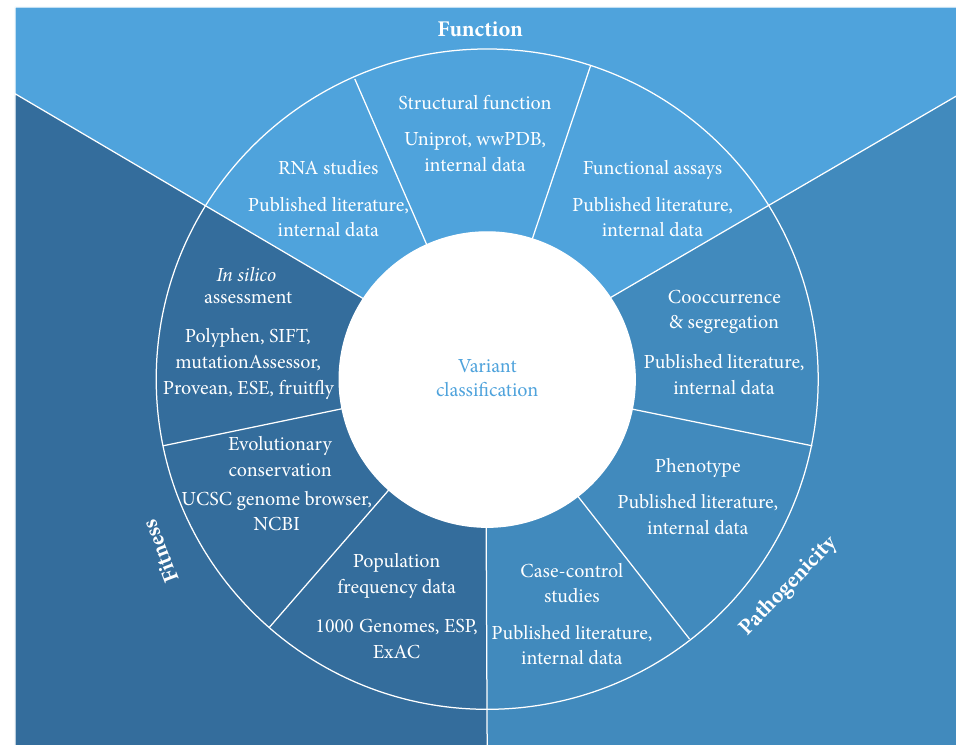
Figure 1: An integrated approach for variant classification. Lines of evidence such as structural function, RNA studies, and functional studies assess the functional impact on the mRNA and protein. Cooccurrence, segregation, case-control studies, and the observed phenotype in variant carriers reflect the pathogenicity of a variant. Population frequency, in silico models, and evolutionary conservation assess fitness of the amino acid or nucleotide